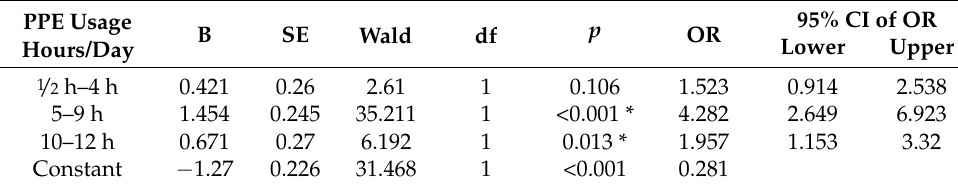
Table 5. Logistic Regression of PPE Use and